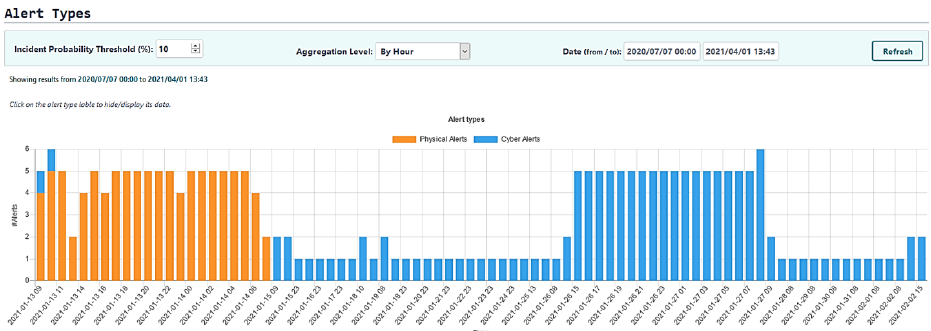
Figure 19. Alert Types